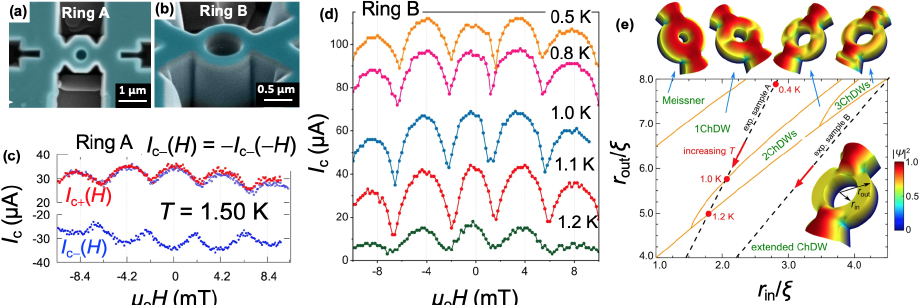
Figure 3. False-colour scanning electron micrographs of two SRO214 micro rings both have the same outer radius of r out = 0.55 µ m, while ( a ) for ring A, the inner radius r in is 0.3 µ m and ( b ) for ring B r in = 0.23 µ m. ( c ) Magnetic-field-dependent critical current I c ( H ) at 1.50 K of ring A. ( d ) I c ( H ) of ring B measured at various temperatures. ( e ) Calculated geometry-dependent phase diagram with illustrations showing the various states within a ring at different points in the phase diagram. The colour maps show the Cooper-pair density | ψ | 2 . In the absence of a magnetic field, for a wider ring, the Meissner state is stable, and the chiral domain walls are stabilised by reducing the width of the ring wall. (Adopted with permission from [61] copyright NPG